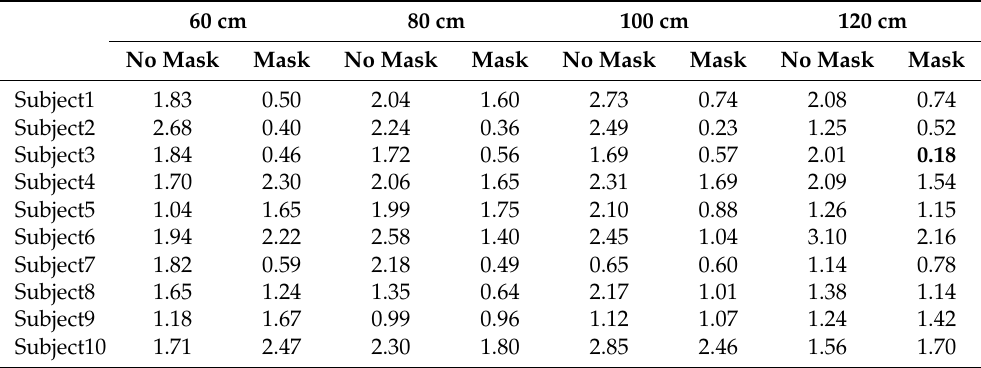
Table 2. Mean absolute error between the estimated RR and the reference RR (unit: breaths/min). Boldface character denotes the best result.